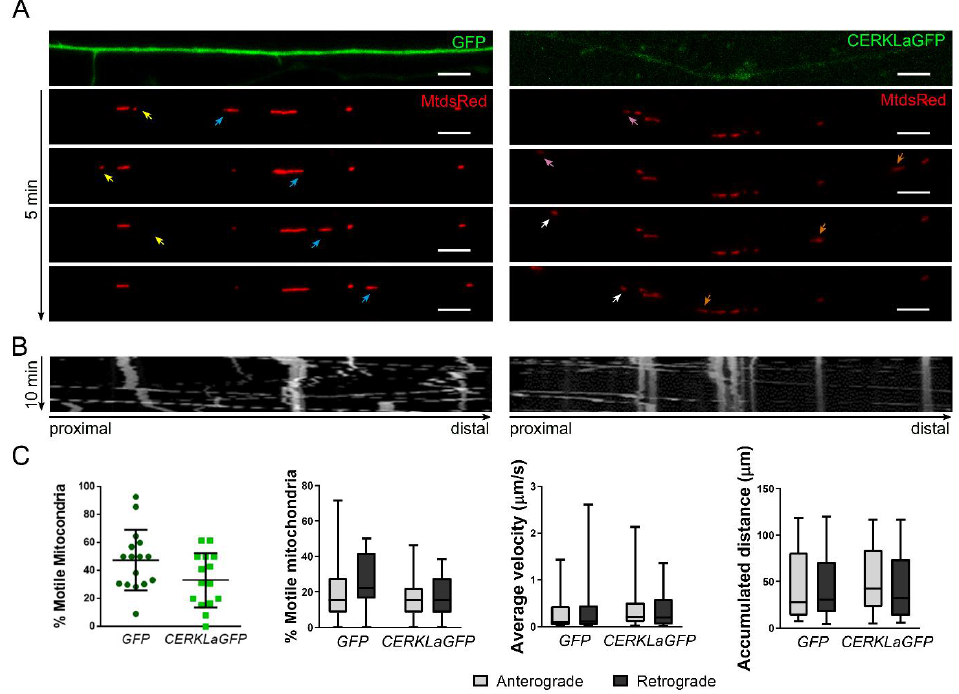
Figure 5. Mitochondrial trafficking is not altered upon CERKL overexpression in hippocampal axons . ( A ) Mitochondrial trafficking live imaging from GFP-(control) and CERKLa-GFP-transfected hippocampal axons (representative images of different timepoints over 5 min). Mitochondria were stained with MitoDsRed. Yellow, pink, and orange arrows indicate mitochondria moving in retrograde direction. Blue and white arrows point to mitochondria moving in anterograde direction. Scale bars: 5 μm. ( B ) Kymographs showing the path of each mitochondrion along the axons for 10 min. ( C ) CERKL overexpression does not alter mitochondrial trafficking in hippocampal axons. Percentage of total motile, anterograde, and retrograde mitochondria is not different between conditions. There are no differences in average velocity and accumulated distance in the axons of CERKLa-GFP-transfected primary hippocampal neurons. Statistical analysis by t -test and two-way ANOVA. n = 35–47 mitochondria from n = 14–15 axons per